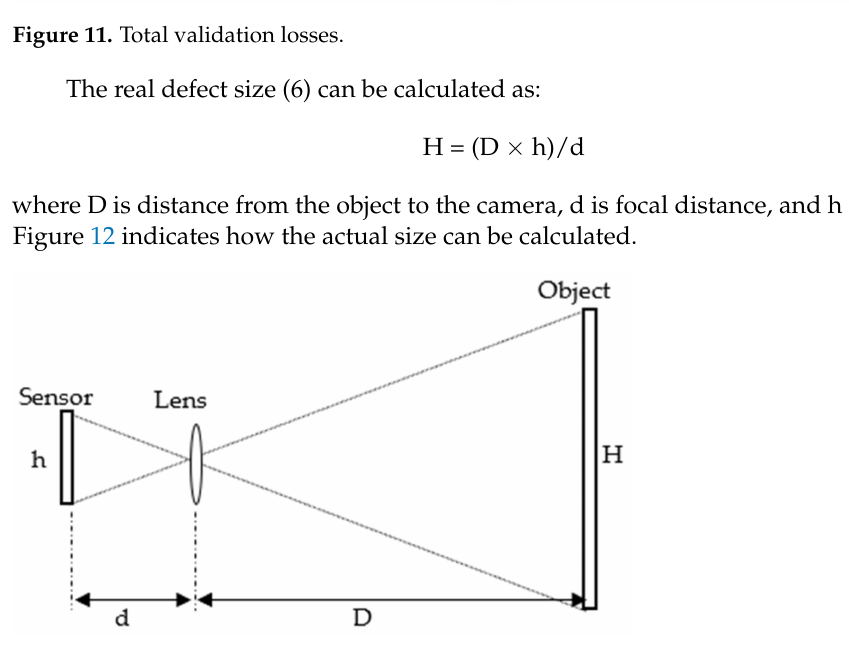
Figure 12. A diagram indicating how the actual size can be